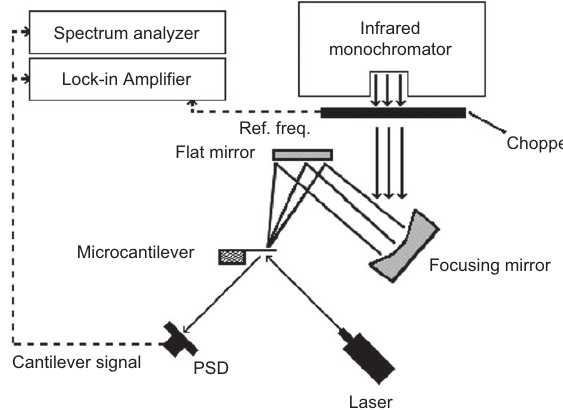
Figure 2 Schematic of the experimental setup used for photother- mal deflection spectroscopy. Reproduced with permission from Krause et al. (2008)